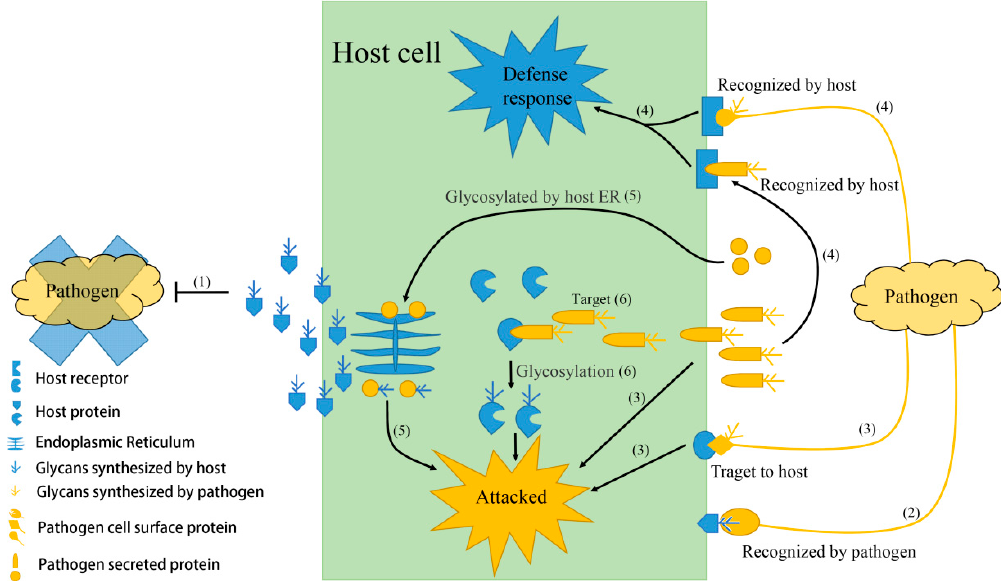
Figure 2. Schematic depicting the multiple functions of glycoproteins in host-pathogen interaction. ( 1 ) Glycoproteins surround the host cell act as barriers to inhibit pathogen adhesion, growth or kill pathogens; ( 2 ) alternatively these glycoproteins are recognized by pathogens to promote infection; ( 3 ) pathogen cell-surface or secreted glycoproteins directly cause disease; ( 4 ) alternatively these pathogen glycoproteins are recognized by host receptors to trigger defense responses; ( 5 ) pathogens also secrete non-glycoproteins to hosts and, subsequently be glycosylated in host endoplasmic reticulum (ER) before they turn pathogenic; ( 6 ) proteins secreted from pathogens can target and glycosylate key proteins of host intracellular signal pathway to cause disease.